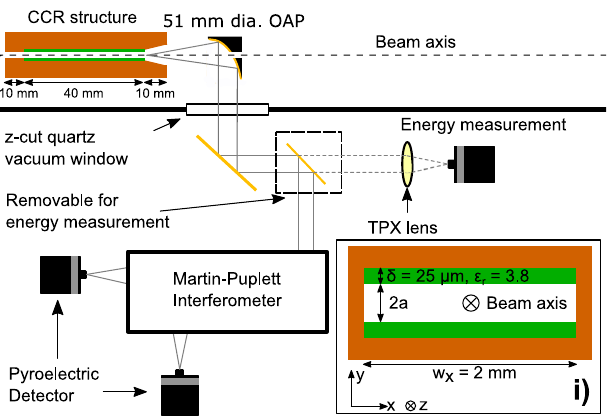
FIG. 1. Experimental setup. The CCR was collected by a 51 mm diameter off axis parabolic (OAP) mirror with a hole to pass the electron beam. TPX lenses were used for focusing of the CCR onto the detectors. All mirrors were gold coated and polished to optical finish. An additional pyroelectric detector (not shown) was used for shot-to-shot subtraction of environmental noise. Inset i), cross-section of the DLW with coordinate system and parameter